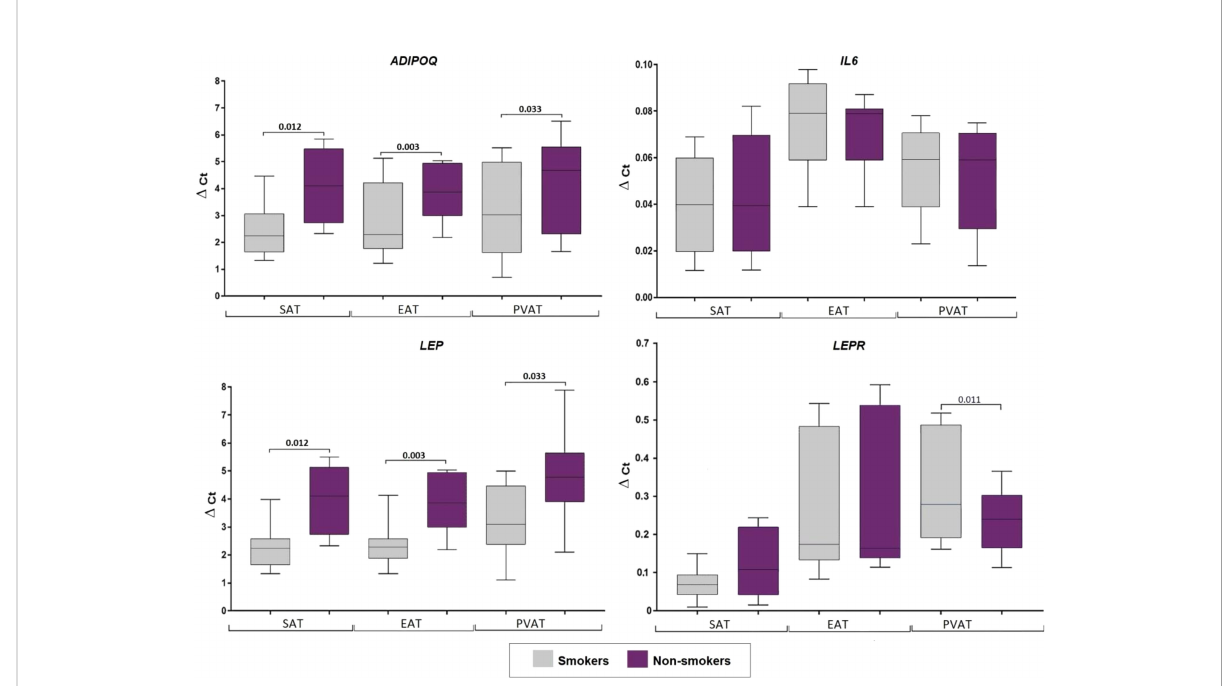
FIGURE 6 Adipocytokine gene expression in the culture medium of adipocytes collected from adipose tissue based on smoking status in coronary artery disease patients. Data are presented in Me (Q1; Q3). SAT, subcutaneous adi-pose tissue; EAT, epicardial adipose tissue; PVAT, perivascular adipose tissue; p, level of statistical signi fi cance; sOB-R, soluble leptin receptor; IL6, interleukin